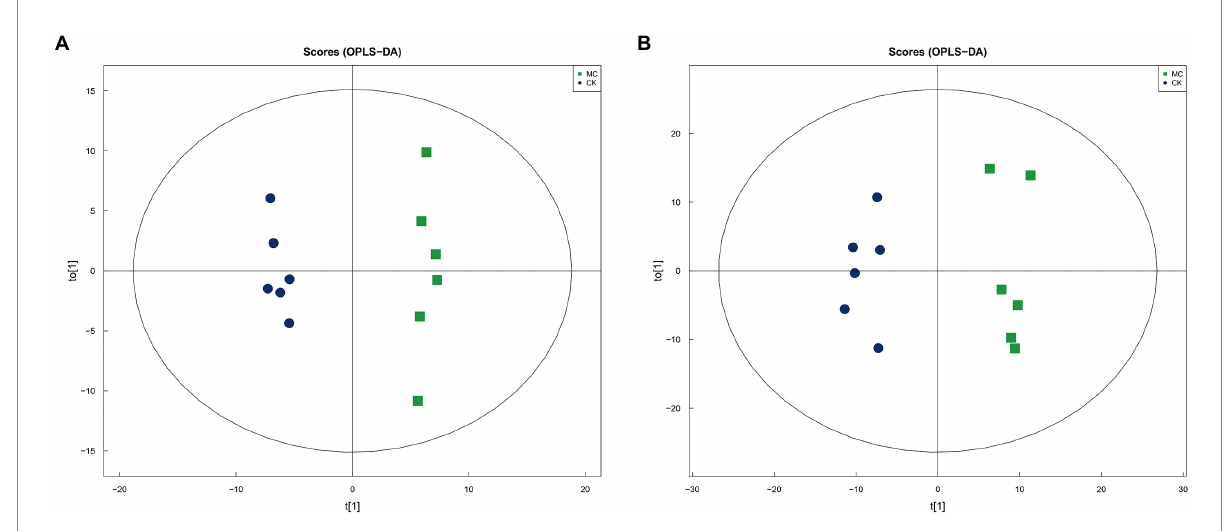
FIGURE 4 OPLS-DA analysis of intestinal metabolites of L . vannamei after MC-LR exposure. (A) Positive ion mode. (B) Negative ion mode